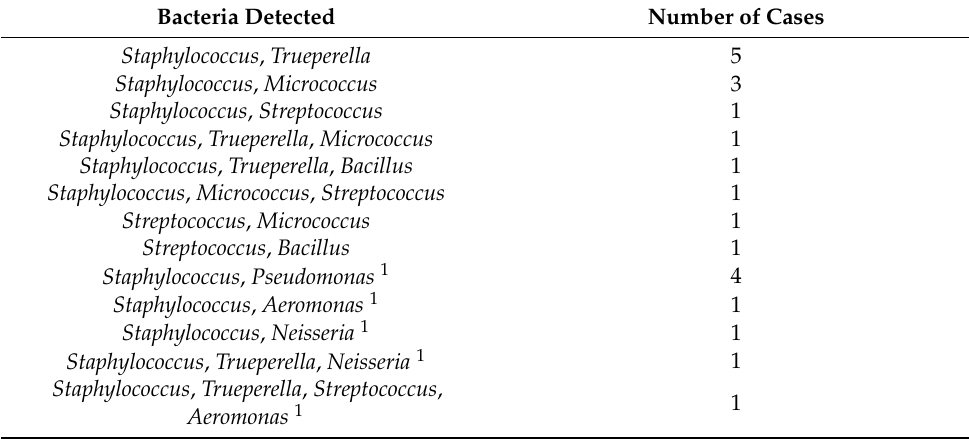
Table 2. The bacterial associations identified in ocular secretion in Saint Bernard